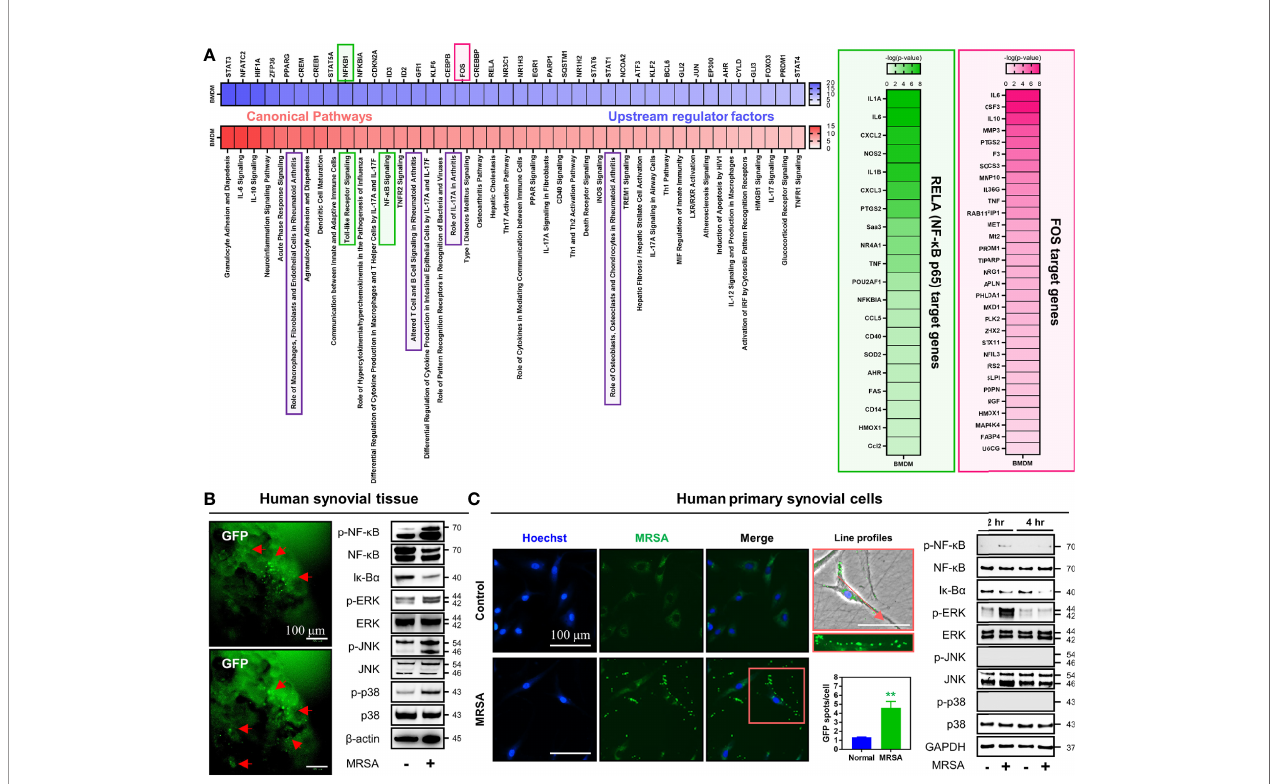
FIGURE 3 | Infection with MRSA triggered NF- k B and MAPK signaling pathways associated with generation of immune responses, in fl ammation, and articular damage. (A) Transcriptome pro fi les were analyzed in primary BMDMs infected for four hours with MRSA using RNA-sequencing. We compared the normalized dataset with non-infected data, determined genes that were signi fi cantly increased in MRSA infection, and then analyzed canonical pathways alongside upstream regulating factors. The downstream genes regulated by NF- k B and FOS were veri fi ed and presented in the heatmap. (B) Human synovial tissue was infected with GFP-labeled MRSA (4×10 6 CFU) for 24 hours and GFP expression was measured as a marker for ongoing infection (Scale bar: 100 m m). The expression of p-NF- k B, NF- k B, I k -B a , p-ERK, ERK, p-JNK, JNK, p-p38, and p38 in whole protein extract obtained from MRSA-infected human synovial tissue was measured; b -actin was used as a loading control. (C) Human primary synovial cells were infected with GFP-labeled MRSA (4×10 6 CFU) for 2 hours, at which time intracellular GFP expression was quanti fi ed (Scale bar: 100 m m). The expression of p-NF- k B, NF- k B, I k -B a , p-ERK, ERK, p-JNK, JNK, p-p38, and p38 in whole protein extract derived from MRSA-infected synovial cells at two and four hours post-infection was measured; b -actin was used as a loading control. Error bars show means ± SD. Two-tailed unpaired t -test analysis was used to assess statistical signi fi cance when compared to the normal group (** p <